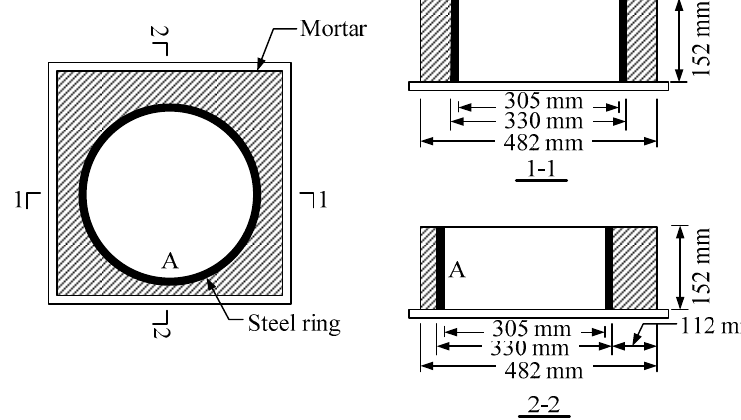
Figure 2 . Test device of restrained squared eccentric ring shrinkage test (RSERST).